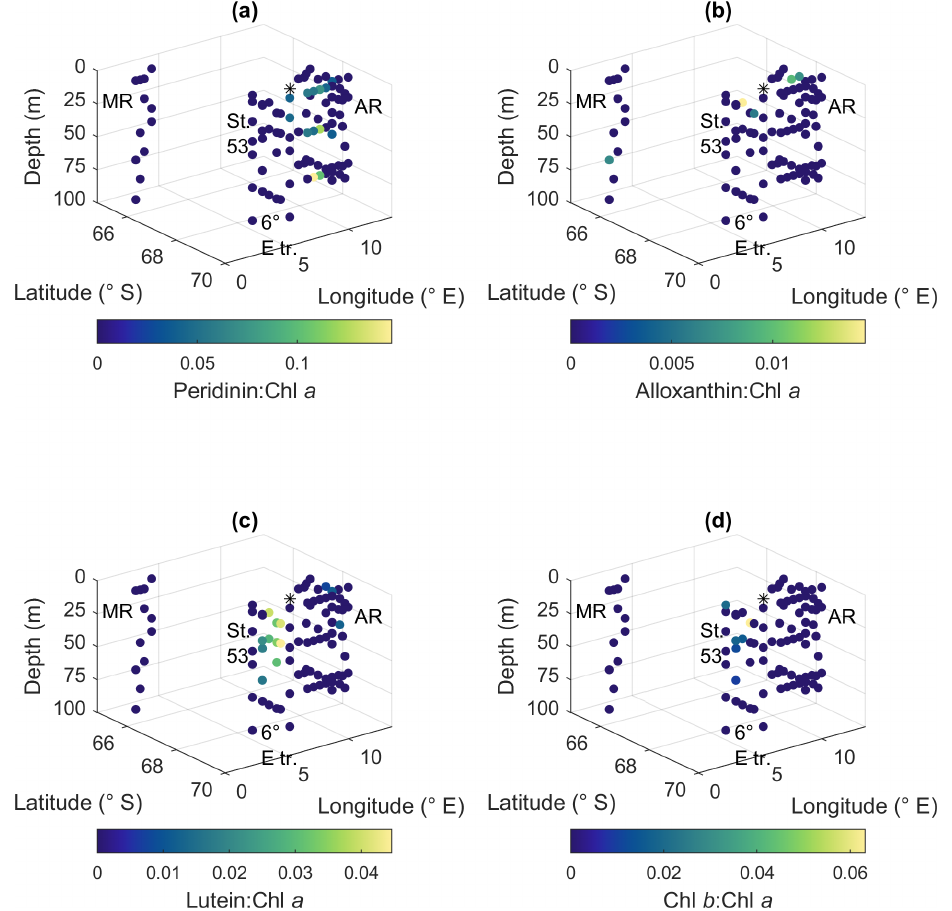
Figure A10. Ratios of algal pigments to Chl a for (a) peridinin, (b) alloxanthin, (c) lutein and (d) Chl b . MR: Maud Rise, St. 53: station 53, AR: Astrid Ridge, 6 ◦ E tr.: 6 ◦ E transect. Station 54 is marked with a black asterisk.